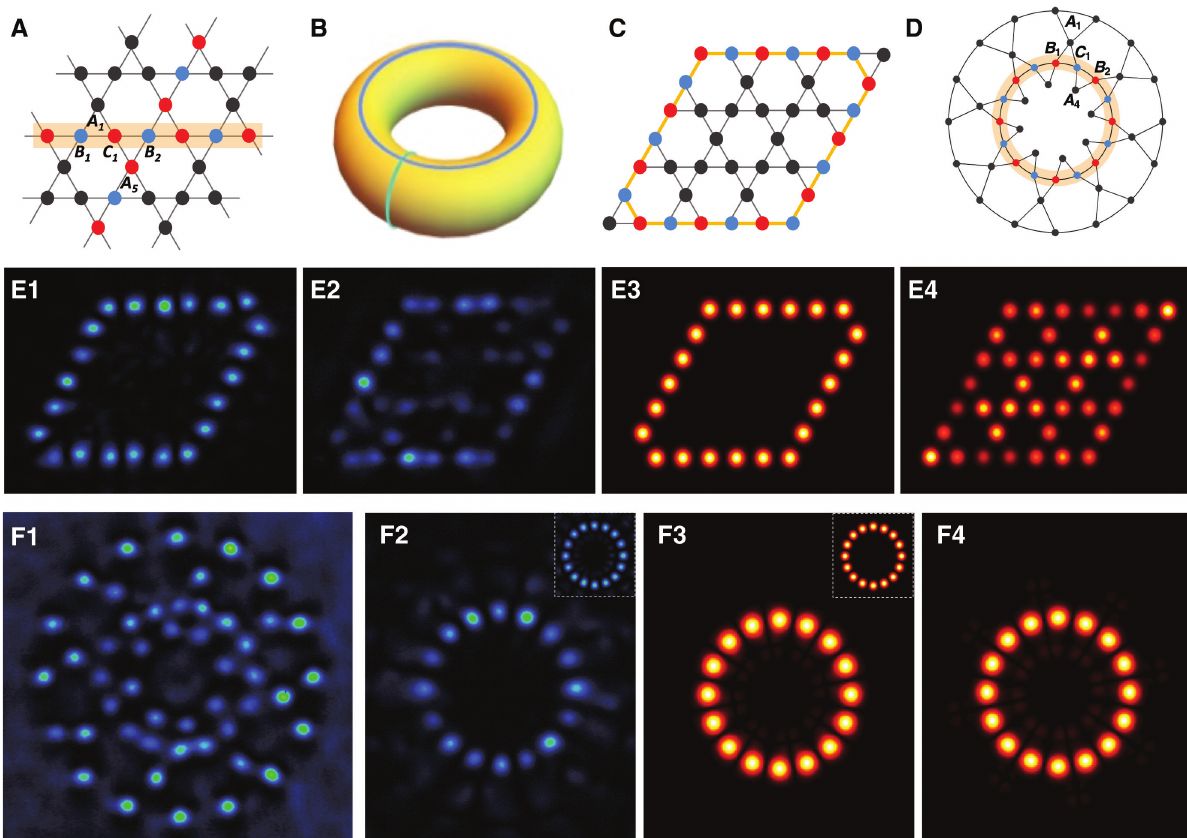
Figure 8: Demonstration of unconventional loop states in a photonic Kagome lattice [86]. (A) Illustration of two NLSs in an infinitely extended Kagome lattice. (B) Illustration of two NLSs winding around a torus, mimicking the 2D infinite lattice. (C) An RBM (orange loop) in a finite Kagome lattice with flat cutting edges. (D) Schematic diagram of a Corbino-shaped Kagome lattice, where the NLS is illustrated by the orange circle. In all figures, black sites are of zero amplitude, while the blue and red ones distinguish nonzero sites with opposite phases. (E) From left to right: (E1, E2) Experimental results of the RBM under out-of-phase and in-phase condition; (E3, E4) Simulation result corresponding to (E1, E2) but for a much longer propagation distance (40 mm). (F) Experimental realization of the Corbino-geometry lattice (F1) corresponding to (D), along with demonstration of the NLS in experiment (F2) and simulations after propagation distance of 10 mm (F3) and 40 mm (F4) under out-of-phase excitation condition. Insets are from input ring necklace of the probe